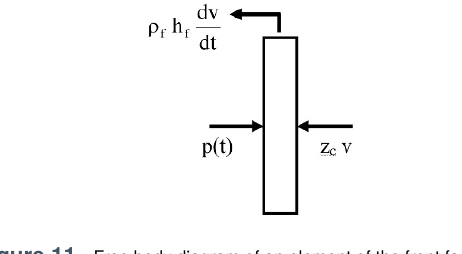
Figure 11. Free body diagram of an element of the front facesheet under and external pressure p ( t ) and the reaction from an elastic